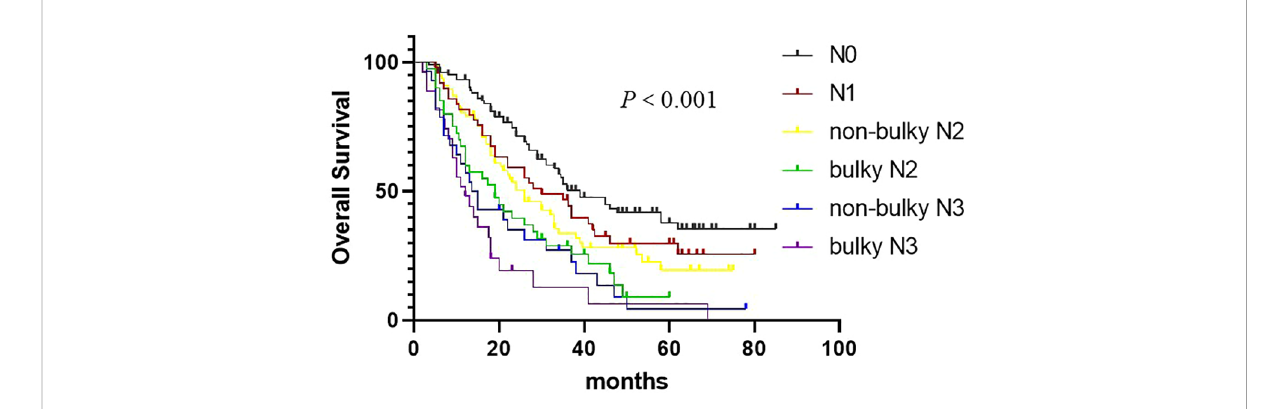
FIGURE 3 Overall survival in non – small cell lung cancer patients according to the cN